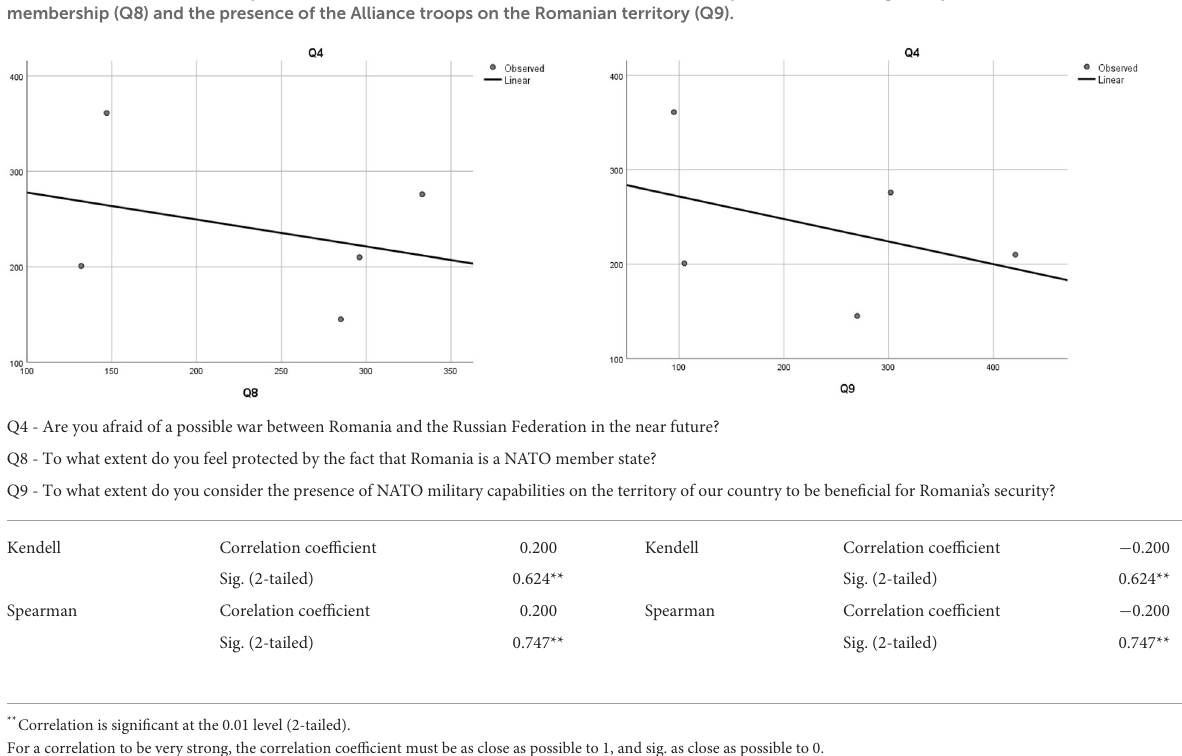
TABLE 12 Correlation of the question that aims to measure the fear of war (Q4) and the questions measuring the opinion on Romania’s NATO membership (Q8) and the presence of the Alliance troops on the Romanian territory (Q9).